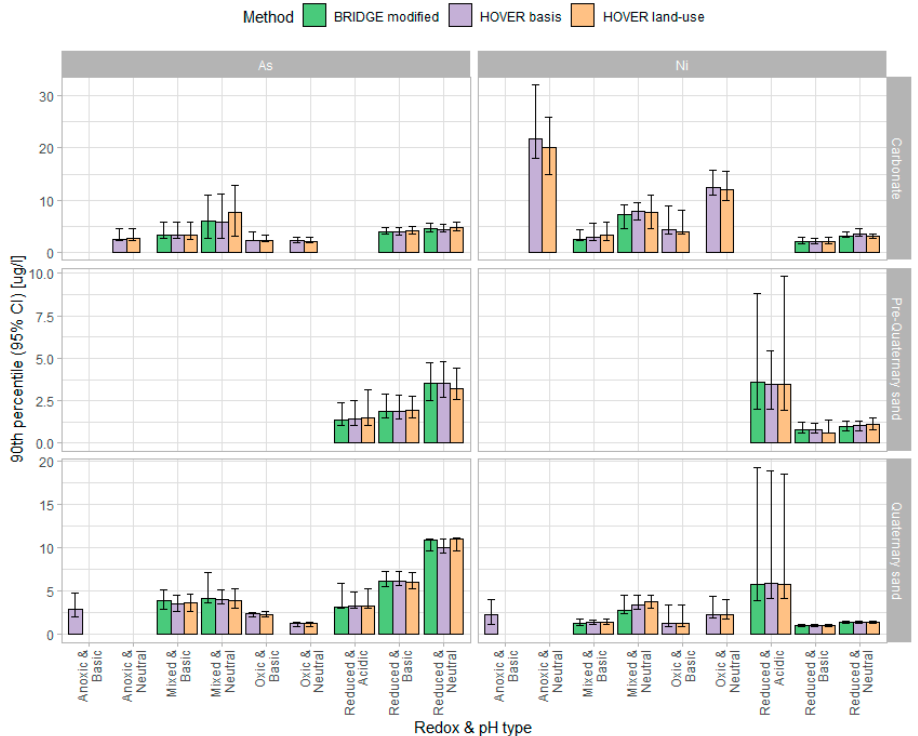
Figure 8. NBLs (y-axis, µg/L) for As and Ni (gray panel labels, top) considering the pH and redox (x-axis) of the aquifer types (gray panel labels, right). No significant differences are observed based on the 95% confidence interval (CI). Tables S3 and S4 provide values and number of samples.